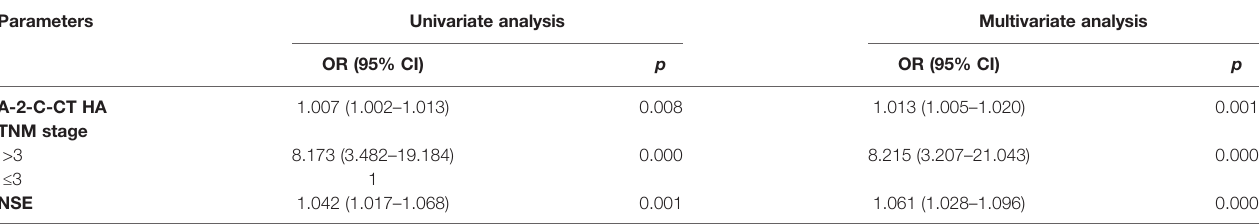
TABLE 4 | Univariate and multivariate Cox regression analyses of variables considered for PFS of SCLC patients.